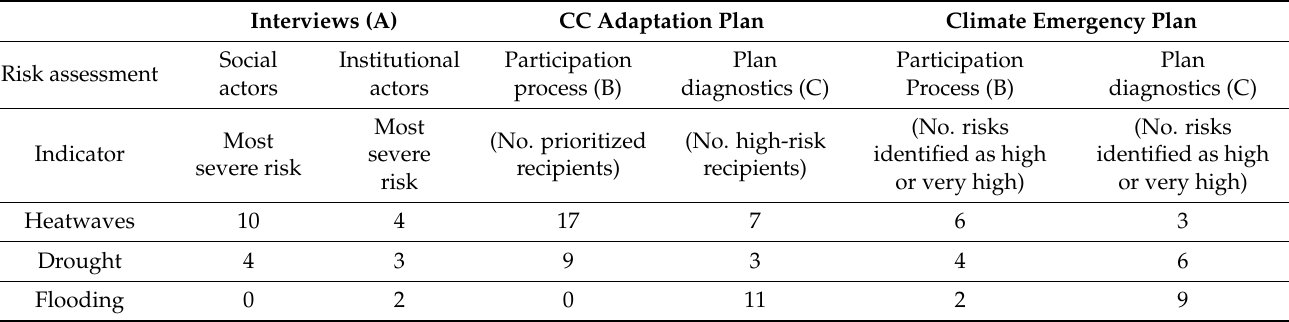
Table 4. Comparative analysis of risk